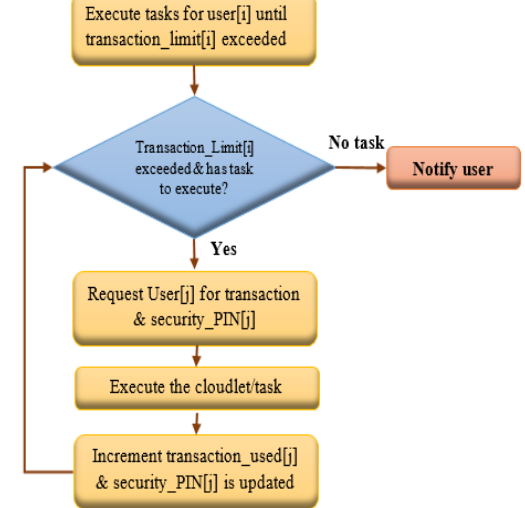
Figure 3. EF-RBAC Algorithm’s working with Flow